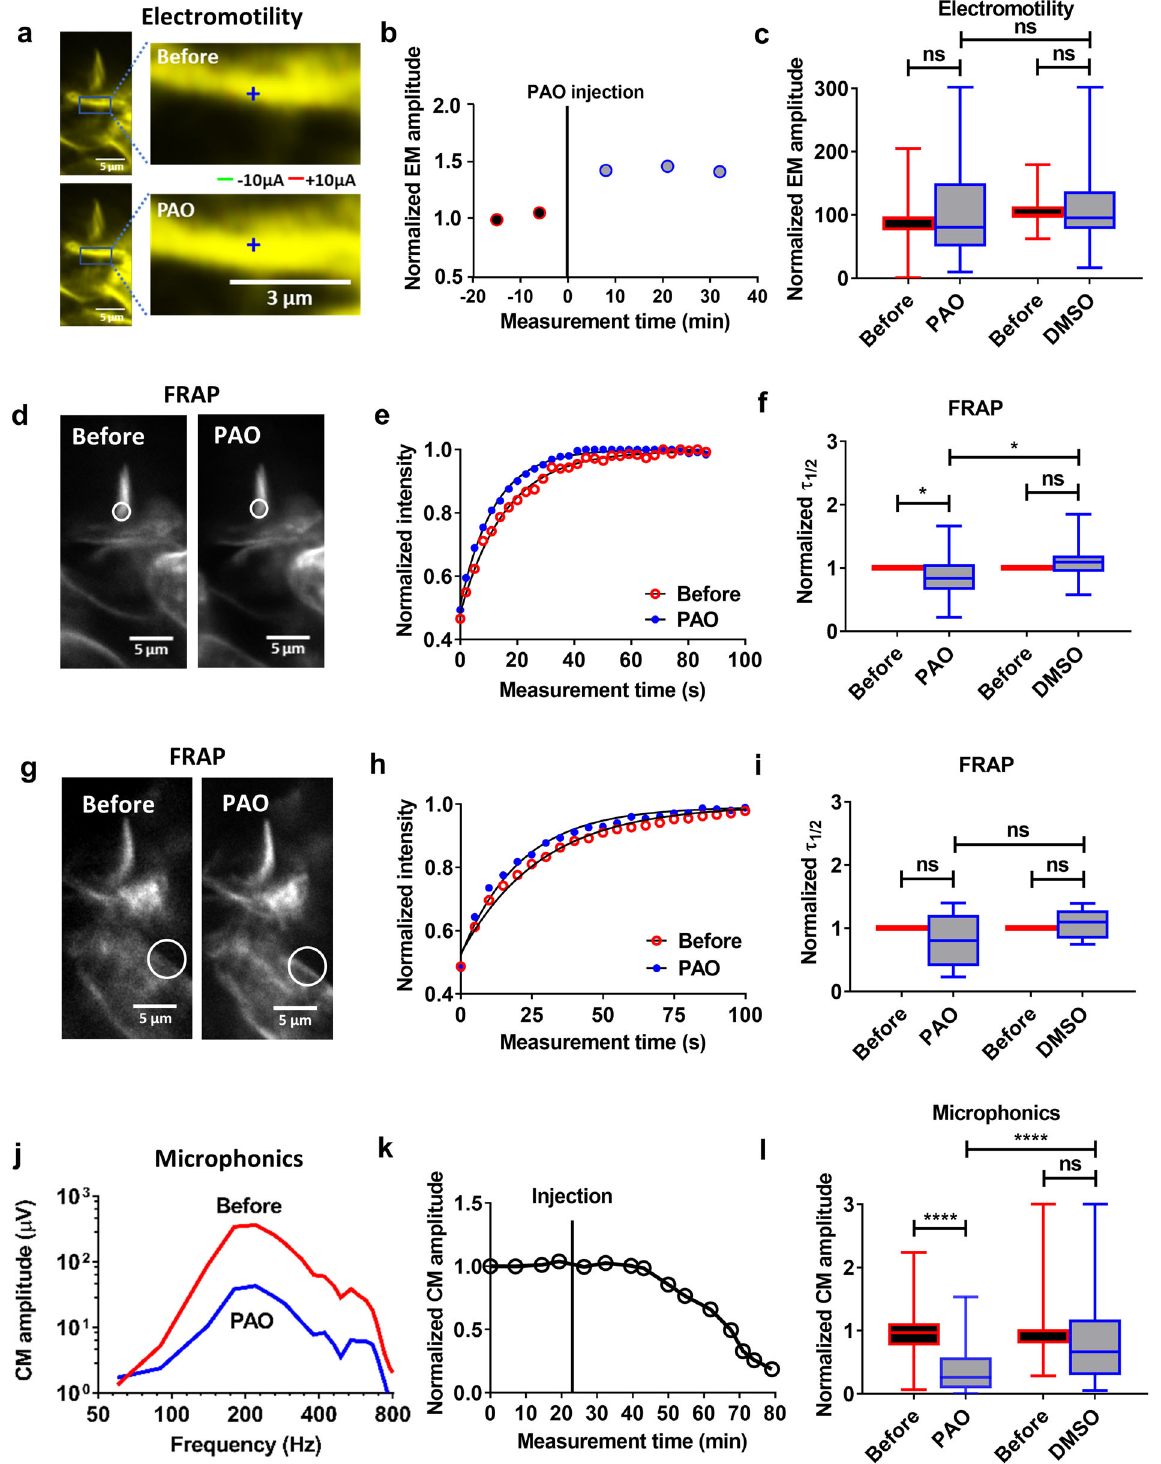
Fig. 7e, a single-phase exponential model (black line) was fi tted to the averaged fl uorescence recovery curve before (red open circle) and 10 min after PAO injection (blue fi lled circles). The fi